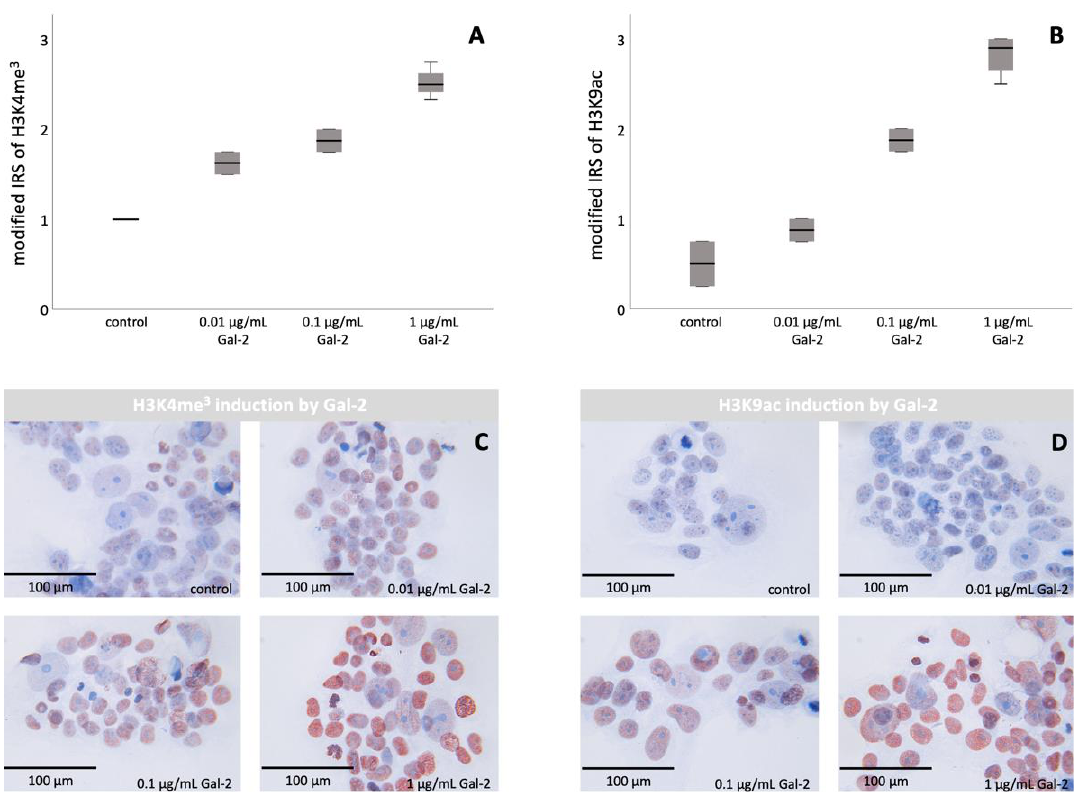
Figure 1. Induction of H3K4me 3 and H3K9ac by increasing the concentration of Gal-2 in BeWo cells: staining results of immunocytochemistry of BeWo cells. ( A , B ) Representation of the staining data as boxplots. ( C ) Representative images of the staining of H3K4me 3 after incubation with increasing Gal-2 concentrations. ( D ) Representative images of the staining of H3K9ac after incubation with increasing Gal-2 concentrations. Scale bar: 200 µm.